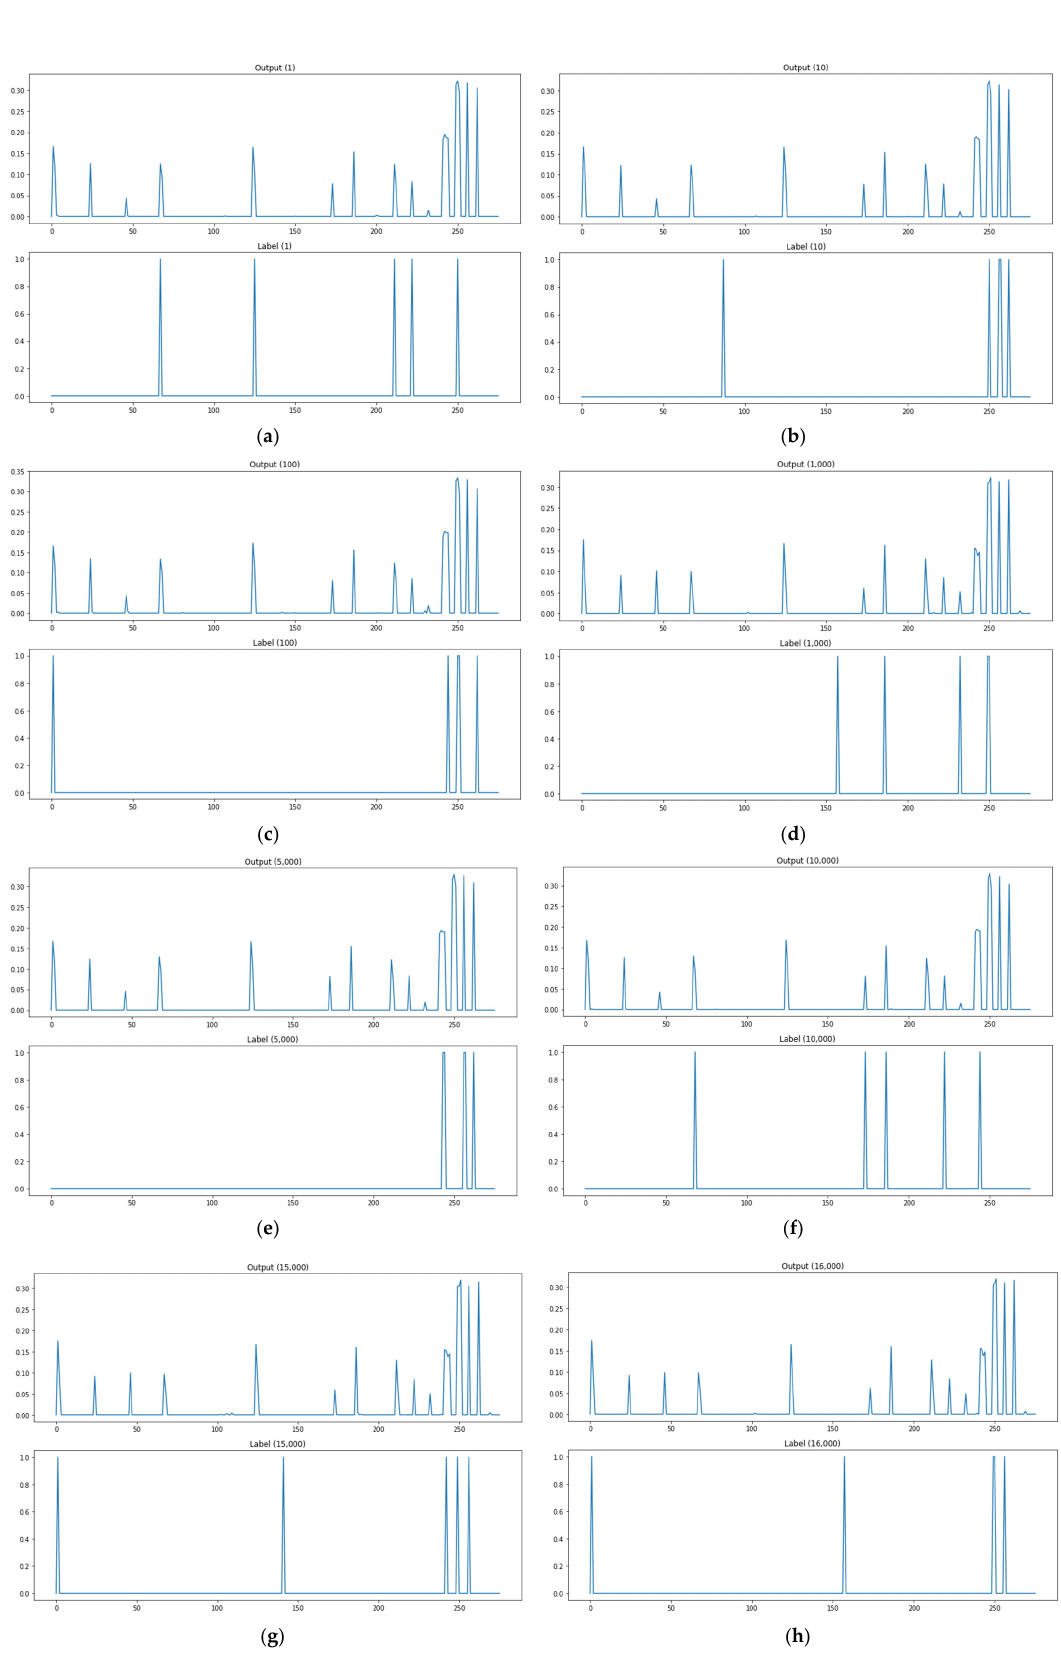
Figure 15. The outputs of the encoding-decoding model (model 4). ( a ) Test data 1. ( b ) Test data 10. ( c ) Path test data 100. ( d ) Path test data 1000. ( e ) Path test data 5000. ( f ) Path test data 10,000. ( g ) Path test data 15,000. ( h ) Path test data 16,000.